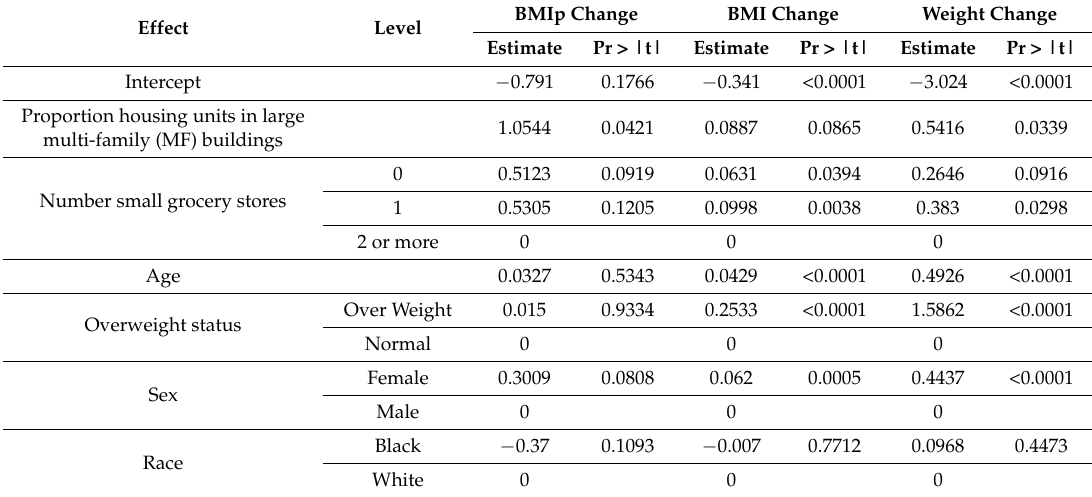
Table 5. Overall Mixed Model: Determinants of change in weight status (Outcome: Fall 2010 − Spring